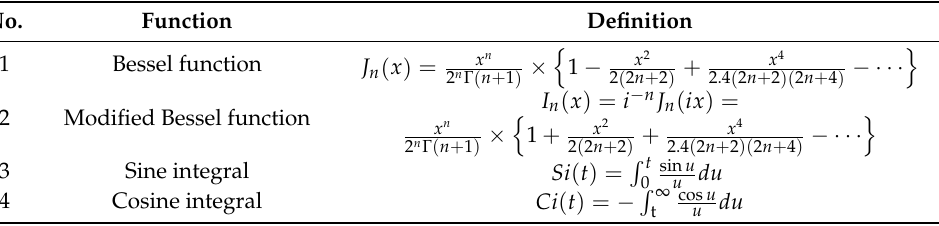
Table A3. Important functions and definitions.